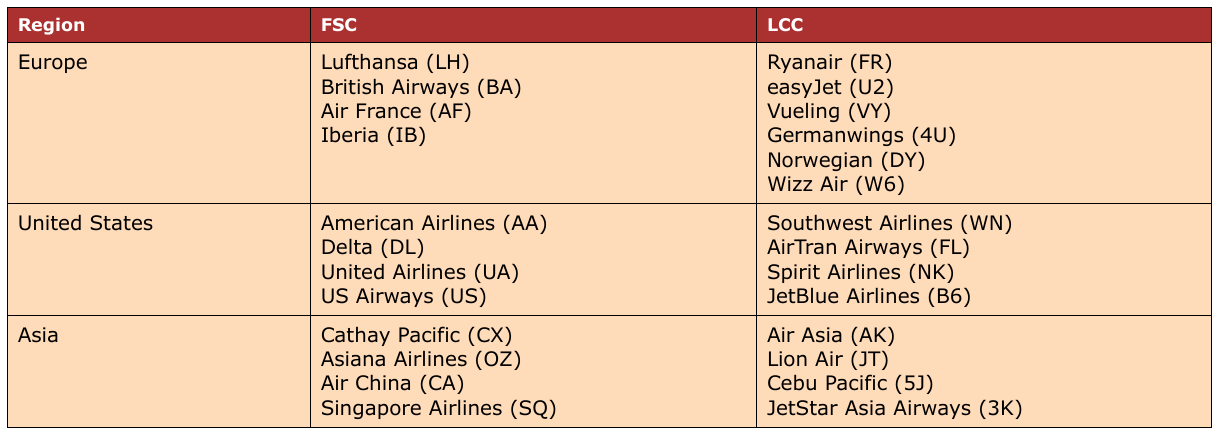
Table 3. Airlines included in the